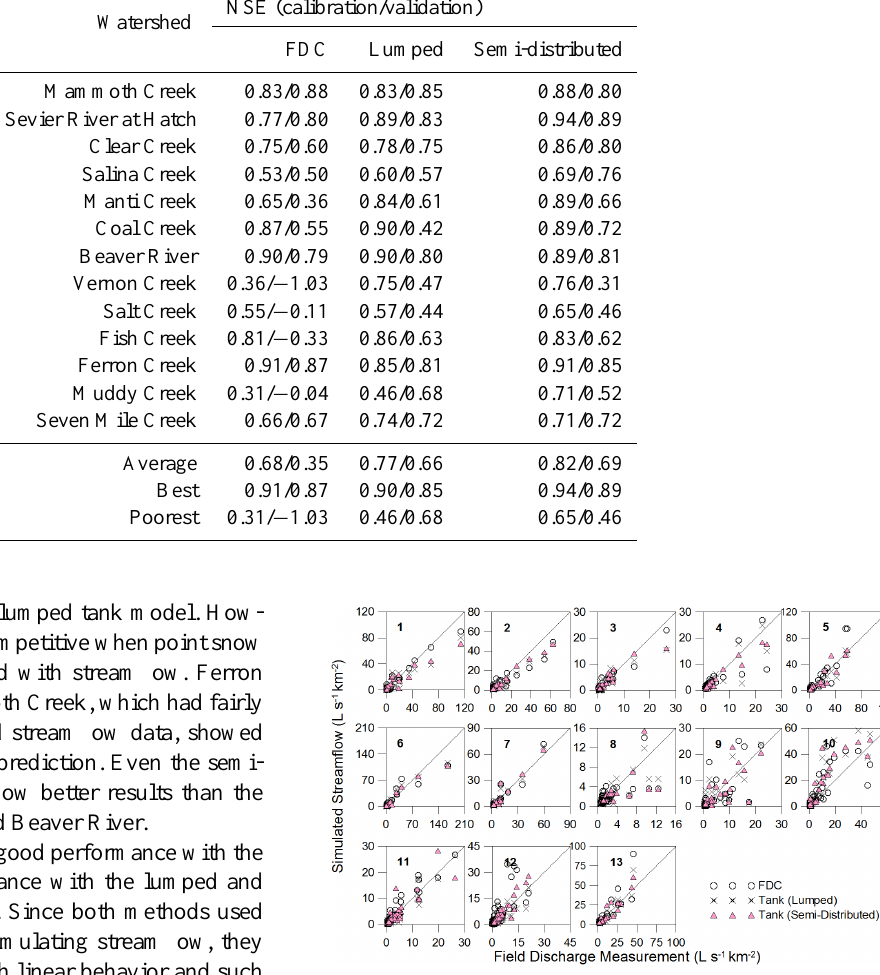
Fig. 6. Comparison between field discharge measurements and streamflow simulations (discharges are normalized by watershed